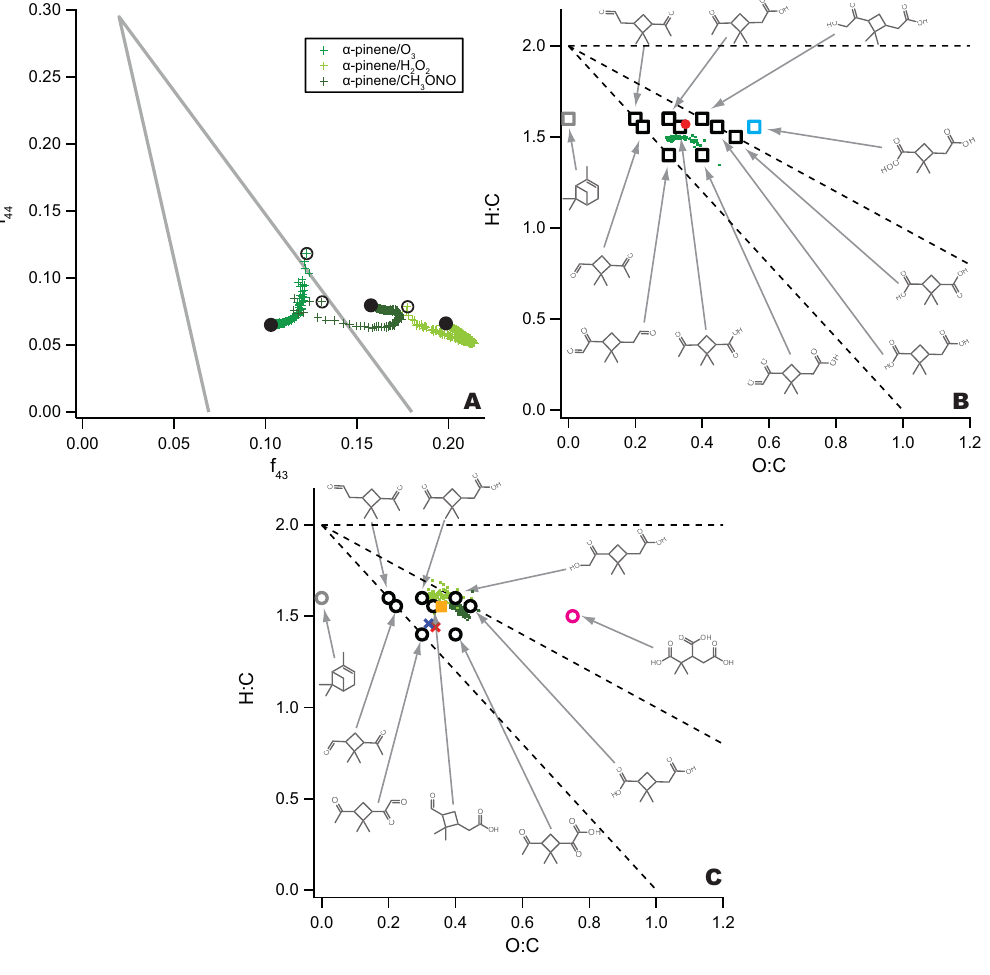
Fig. 2. (A) “Triangle plot” for α -pinene SOA formed from ozonolysis and high- and low-NO x photooxidation. Here and in subsequent figures, the outline of the triangle (Ng et al., 2010) is shown in gray. Open and closed black circles represent the beginning and end of the experiments, respectively. (B) Van Krevelen diagram for SOA formed from α -pinene ozonolysis. α -pinene and SOA products identified by Yu et al. (1999) represented by gray and black boxes respectively. The molar weighted average of the elemental ratios of identified SOA products is represented by the red circle (Chhabra et al., 2010). The blue square denotes peroxypinic acid, a product of α -pinene ozonolysis proposed by Docherty et al. (2005). Here and in subsequent figures, lines with slopes of 0, − 1 and − 2 are represented by dashed lines. (C) Van Krevlen diagram for SOA formed from the high- and low-NO x photooxidation of α -pinene. α -pinene and SOA products identified by Jaoui and Kamens (2001) and Szmigielski et al. (2007) are represented by black and pink circles, respectively. The mass weighted average O/C and H/C calculated from Jaoui and Kamens (2001) is represnted by an orange square. Elemental ratios as measured by FTIR data are represented by red (low-NO x ) and blue (high-NO x )